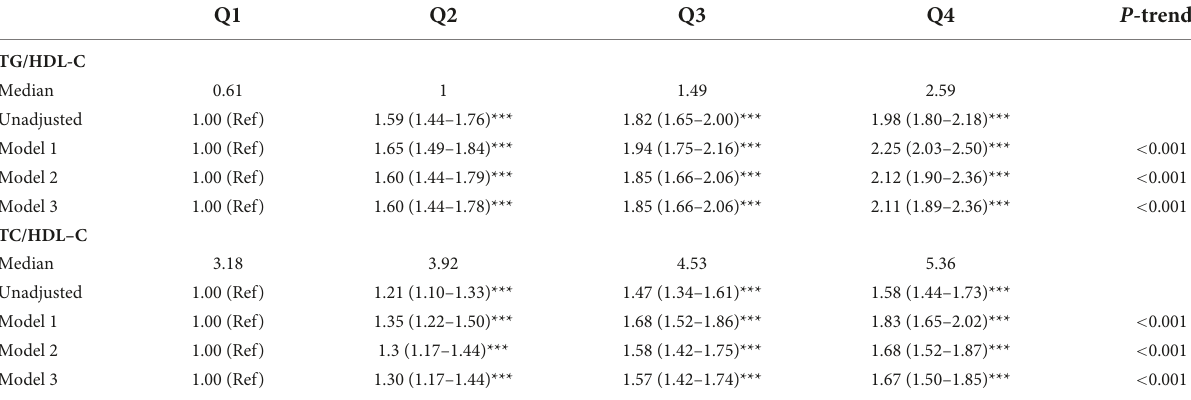
TABLE 2 Logistic regression models assessing the associations of lipid ratios with